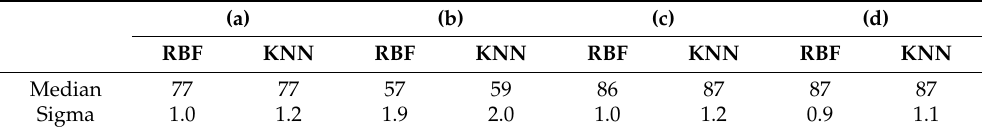
Table 8. F1 score results of the test series with combined feature extraction methods. ( a ) Combination of contour properties and contour moments. ( b ) Image moments of a downscaled ROI. ( c , d ) Combi- nation of scaled ROI and contour moments. ( c ) The 12 × 19 pixel resolution and 24 moments. ( d ) The 12 × 18 pixel resolution and 31